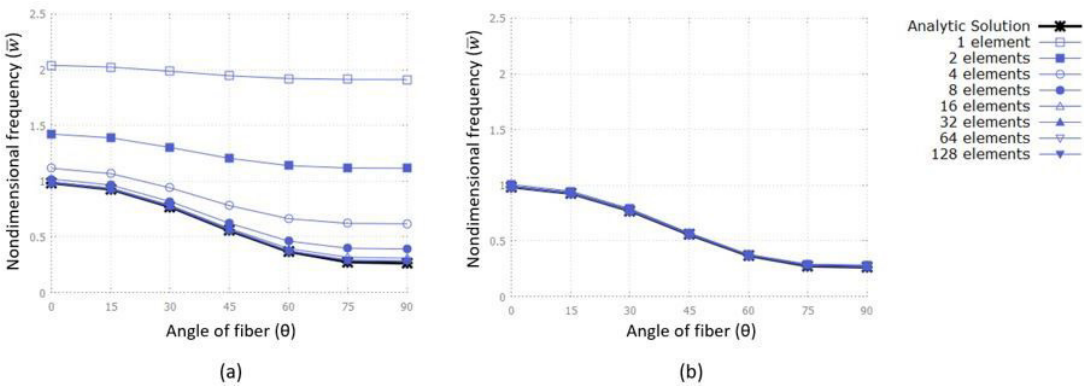
Figure 4. ( a ) First frequency for different ply fiber directions for the clamped-free (CF) beam computed using the parasitic shear finite element model; ( b ) First frequency for different ply fiber directions for the clamped-free (CF) beam computed using the corrected finite element model.